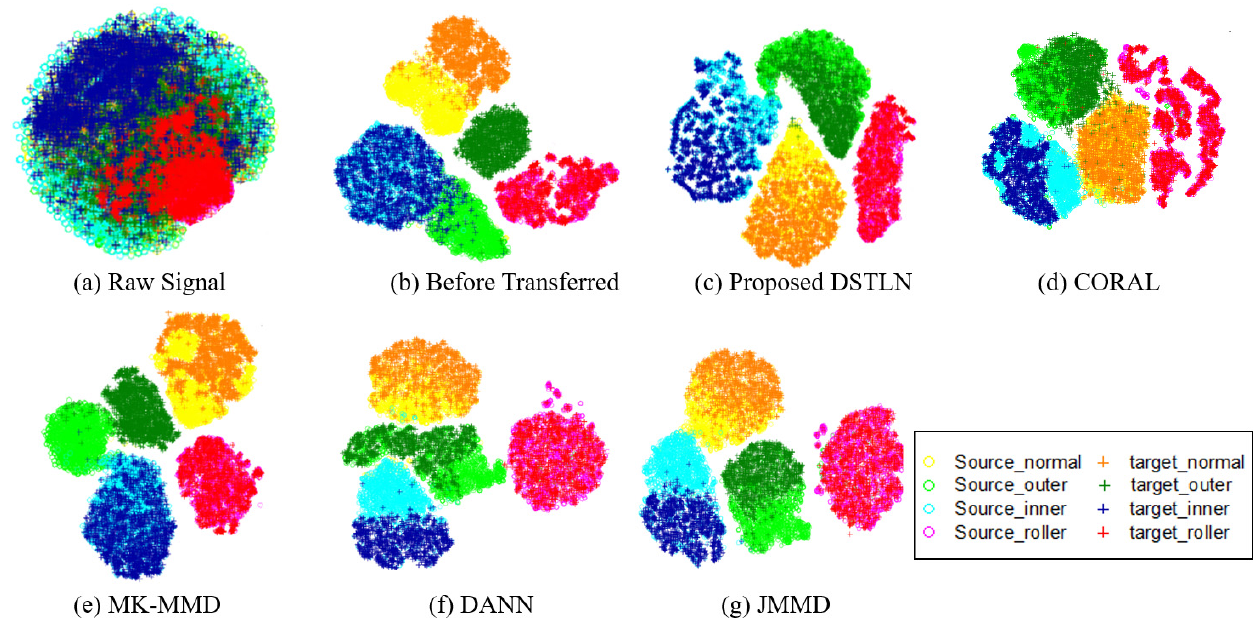
Figure 14. The t-SNE visualization of the learned features in a high-speed train wheelset bearing dataset.